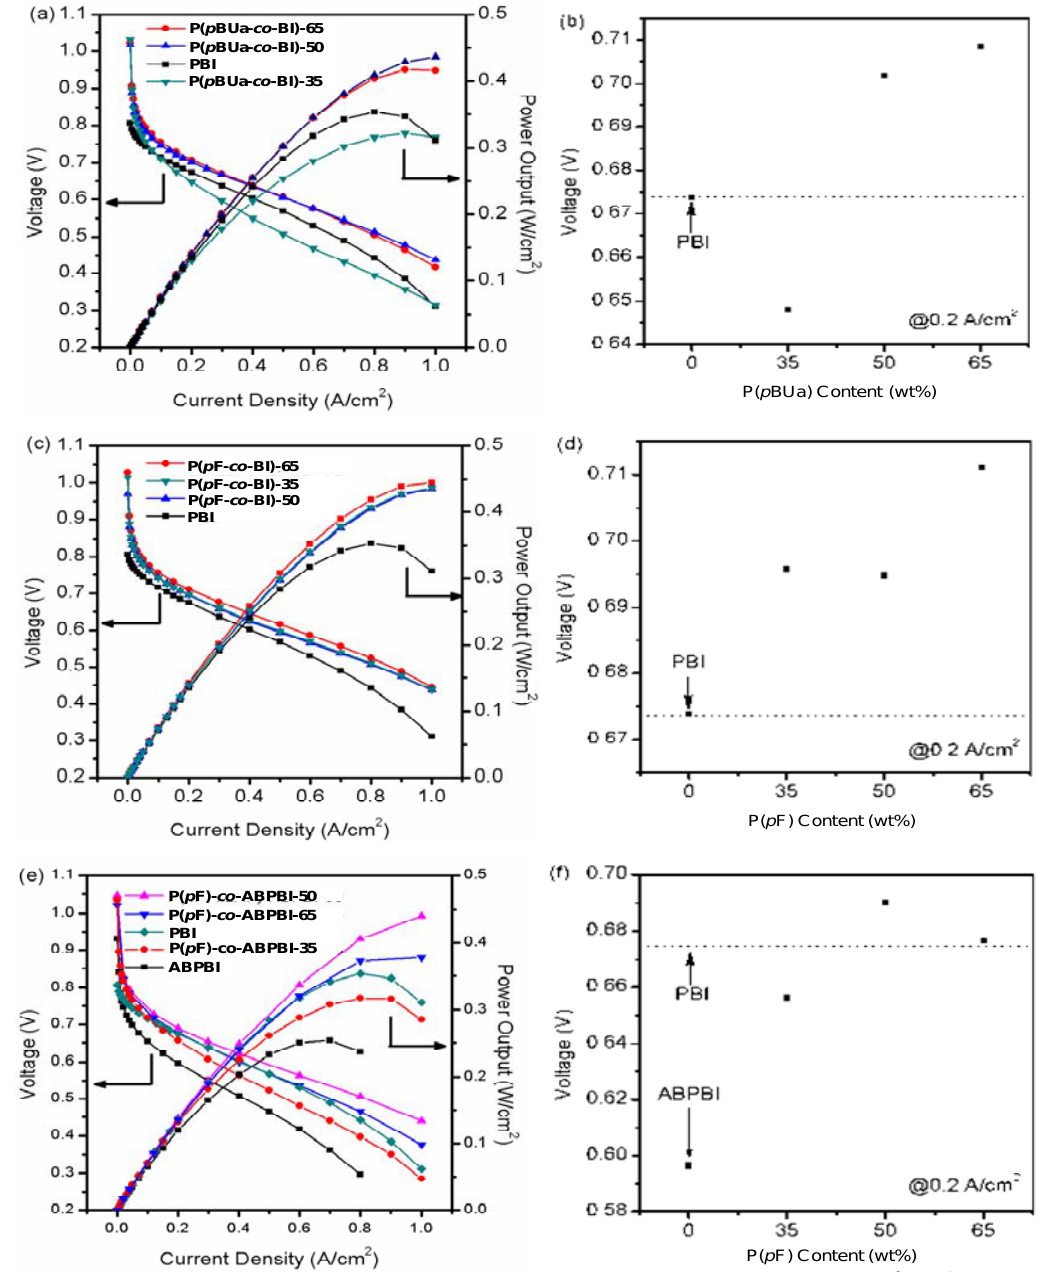
Figure 7. ( a ), ( c ), and ( e ): Polarization and power density curves of PA-doped membranes; ( b ), ( d ), and ( f ): Cell voltage with the BOA content at 0.2 A cm − 2 , 150 °C, non-humidified and air, cathode; 0.9 mg cm − 2 PtRu loading, anode; 1.7 mg cm − 2 PtCo H 2